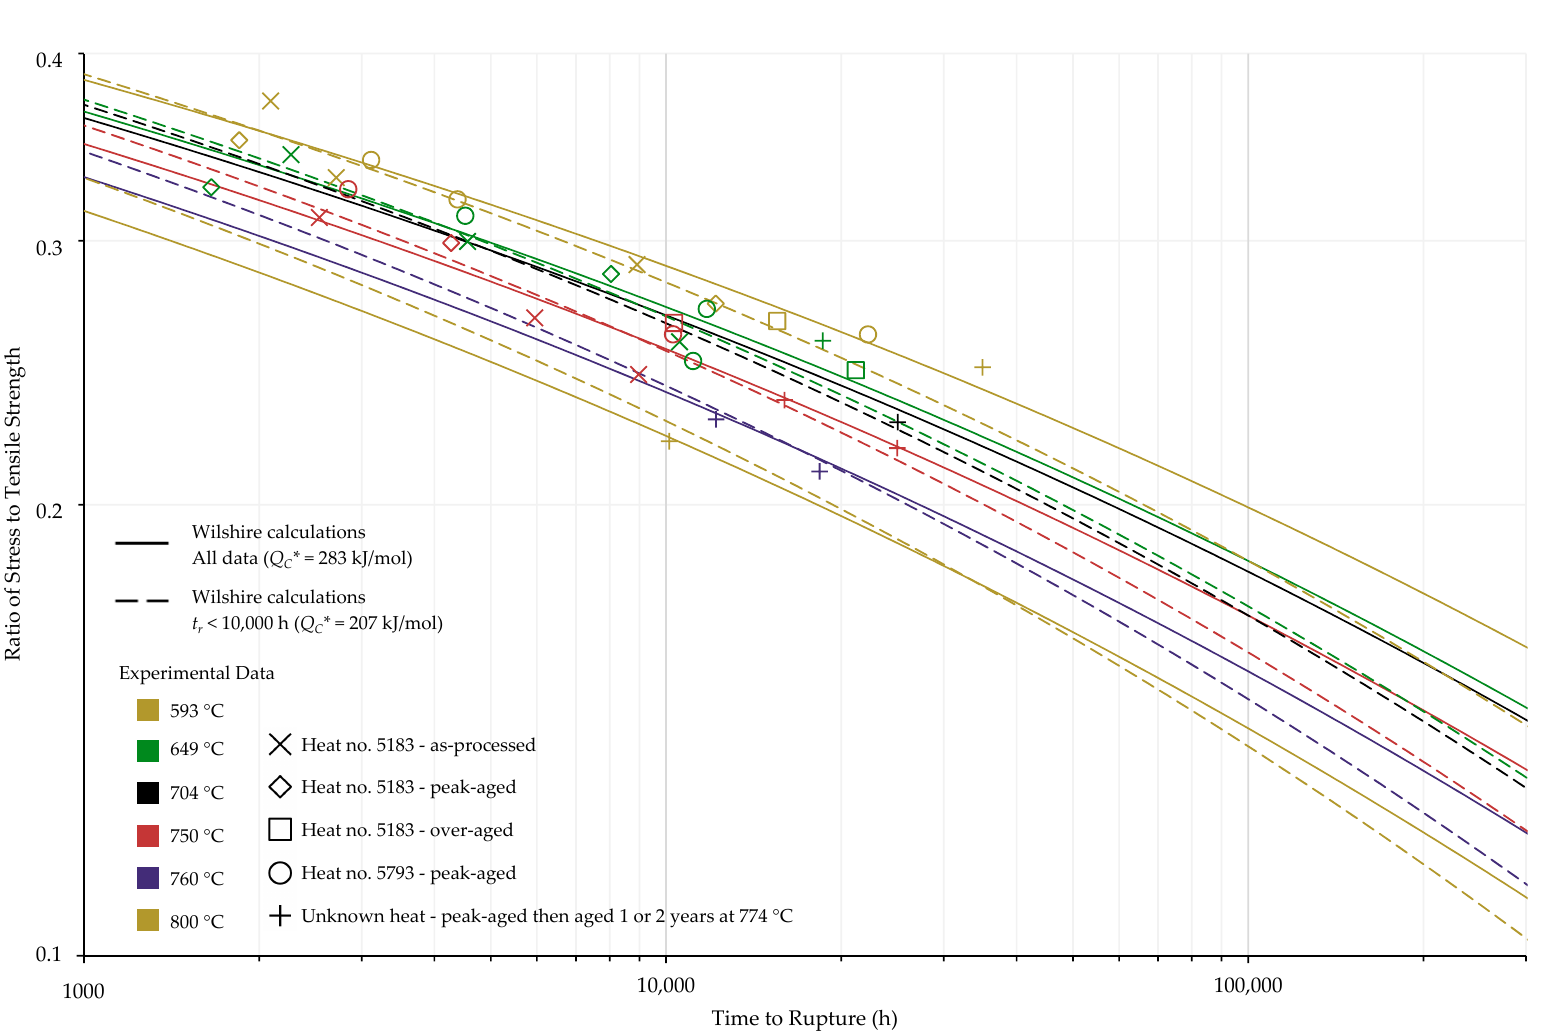
determined using C